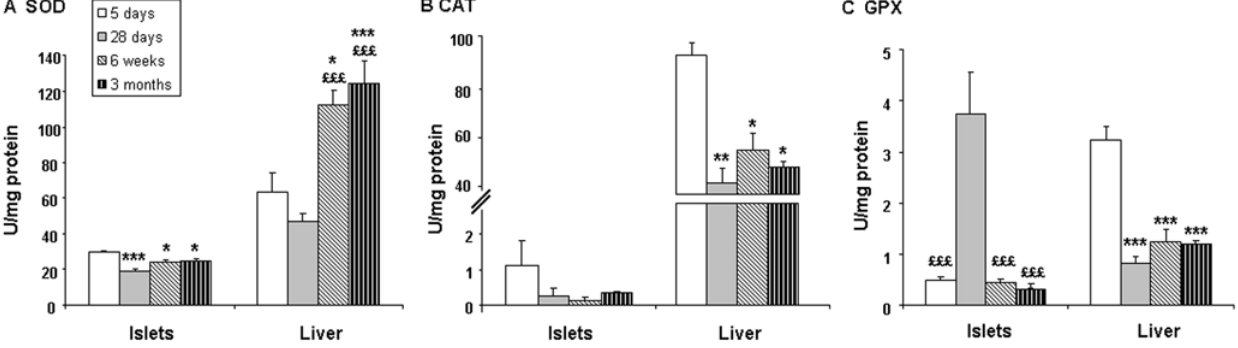
Figure 2. Postnatal evolution of antioxidant enzyme activity in pancreatic islets and liver. (A) SOD, (B) CAT, (C) GPX. Results are expressed as means 6 SEM; n=4–7 independent experiments. *p , 0.05, **p , 0.01, ***p , 0.001 vs 5 days; £p , 0.05, ££p , 0.01, £££p , 0.001 vs 28 days within the same tissue.